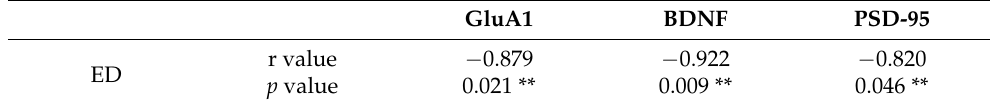
Table 2. Correlations between different molecular alterations and behavioral activities. GluA1 BDNF PSD-95 r value − 0.879 − 0.922 − 0.820 ED p value 0.021 ** 0.009 ** 0.046